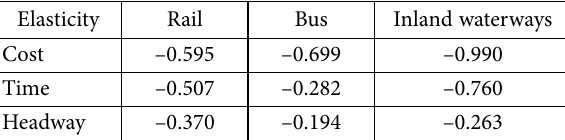
Table 3. Direct elasticities obtained from mode choice